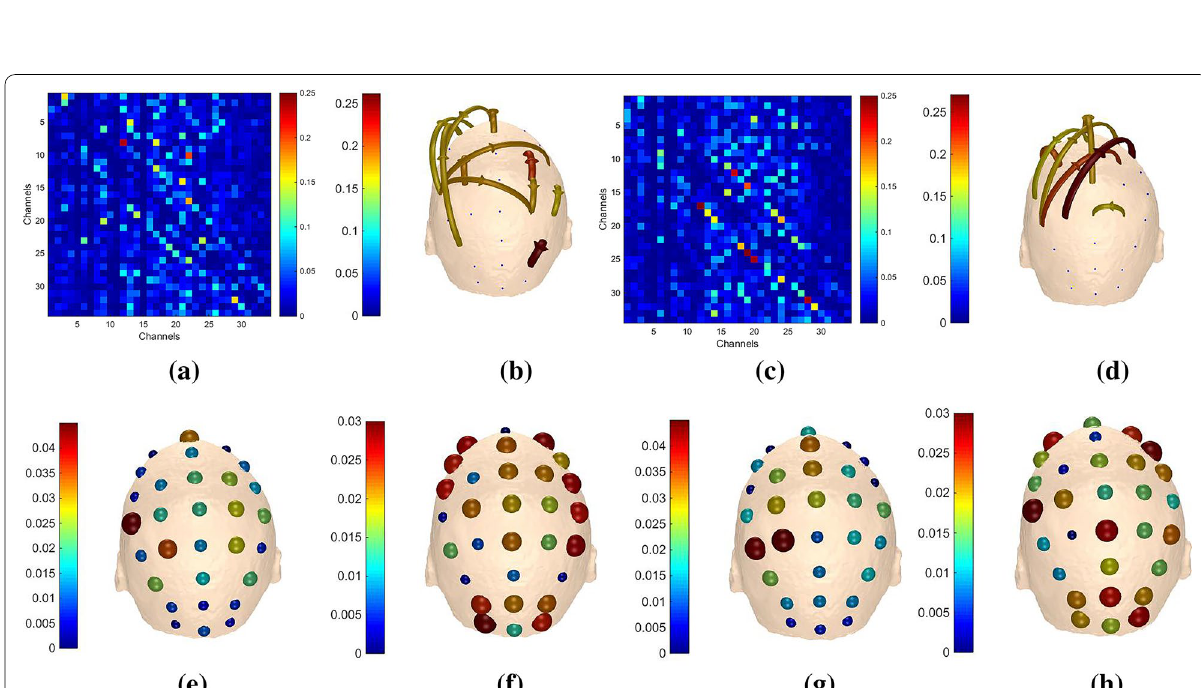
Fig. 11 Inflows of ‘k3b’ in α frequency band a m and f m 3 for ‘RH’ task =